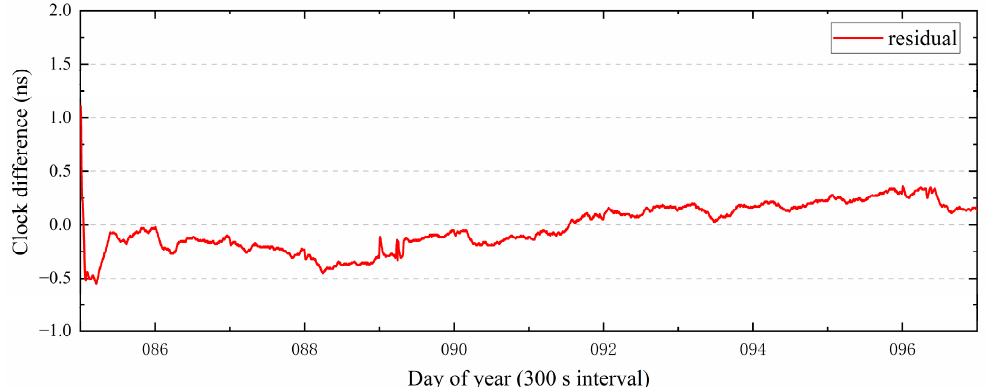
Figure 14. The difference in NTSC-TL time comparison between the PPP-B2b product and the GBM product via PPP.